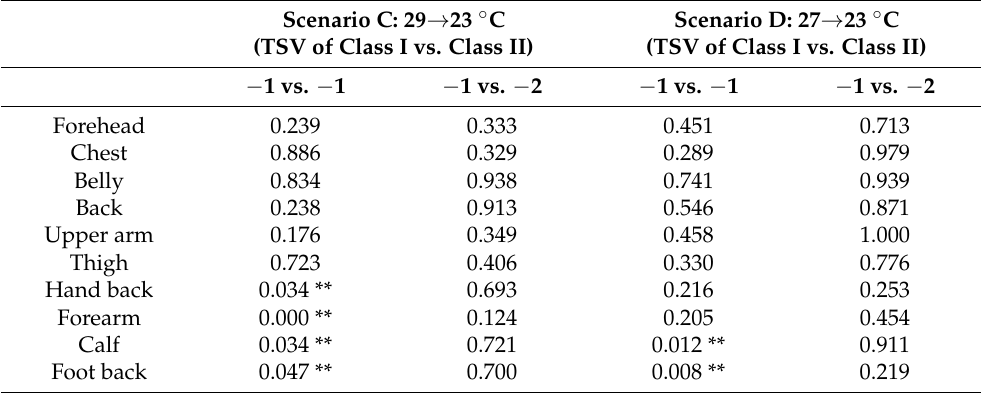
Figure 12. Interval plot of local skin temperature by thermal sensation of ten body parts of Class I and Class II in scenario C (29 → 23 ◦ C). Vertical bars represent 95% CI for the mean, and ** denotes a significant difference between two TSV values ( p < 0.05). Table 4. p -value of two-sample t -test of local skin temperature of ten body parts of Class I and Class II for scenario C and